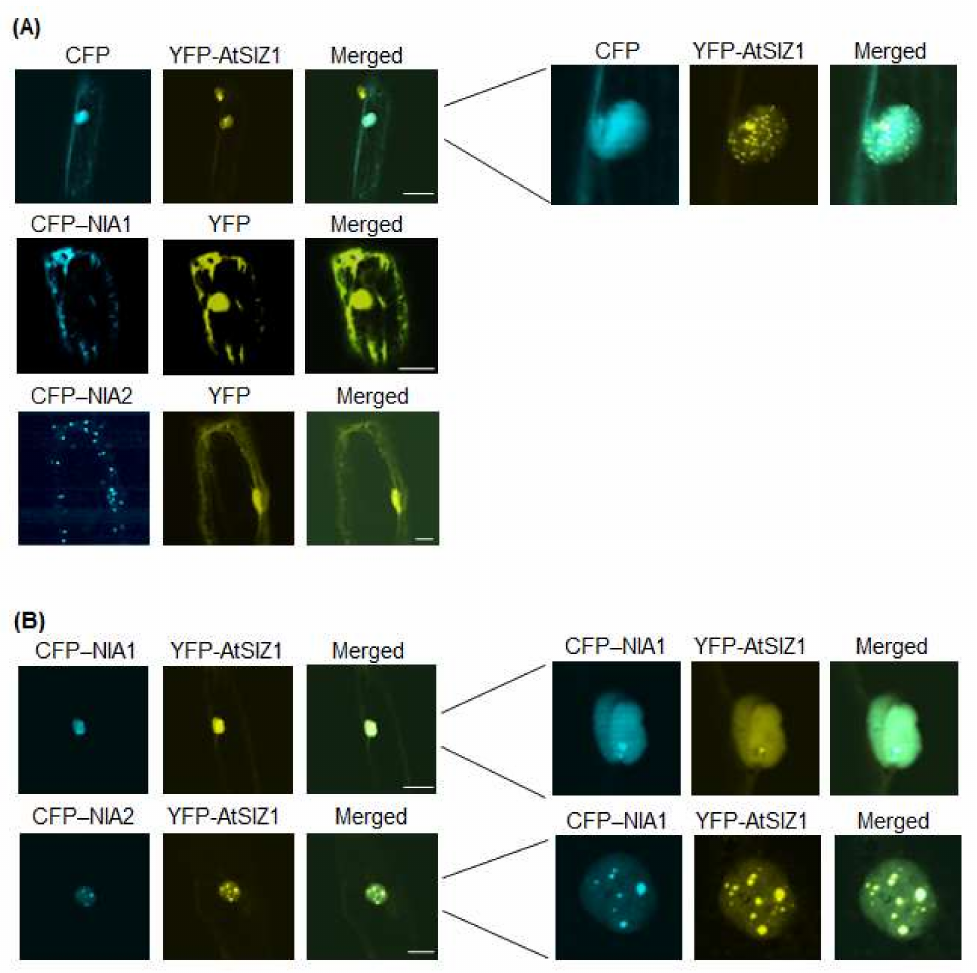
Figure 1. Subcellular localization of AtSIZ1 and NR proteins NIA1 and NIA2. Localization of NIA1, NIA2, and AtSIZ1 was investigated by particle bombardment of onion epidermal cells. Constructs harboring 35S-CFP-NIA1 , 35S-CFP-NIA2 , and 35S-YFP-AtSIZ1 were introduced into onion epidermal cells by particle bombardment alone ( A ) or in combination ( B ). After incubation at 25 ◦ C in the dark for 16 h, the bombarded tissues were analyzed by confocal microscopy to visualize transient CRP or YFP expression. CFP-NIA1, CFP-NIA2, and YFP-AtSIZ1 refer to CFP and YFP fused to the C-terminus of NIA1, NIA2, and AtSIZ1, respectively. DIC, differential interference contrast. Bar, 50 µ